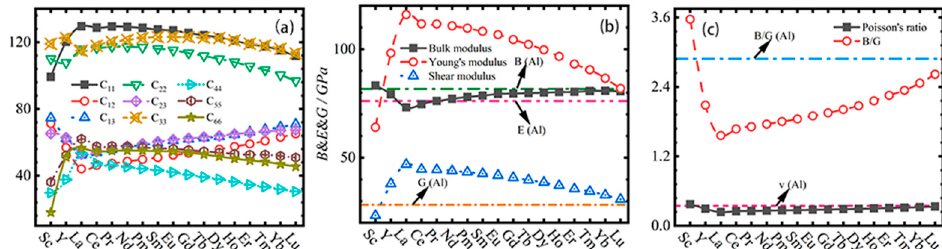
Figure 2. ( a ) Calculated elastic constant of Al 11 RE 3 ; ( b ) Young’s modulus E, shear modulus G, bulk modulus B values; ( c ) Poisson’s ratio v and B/G values.